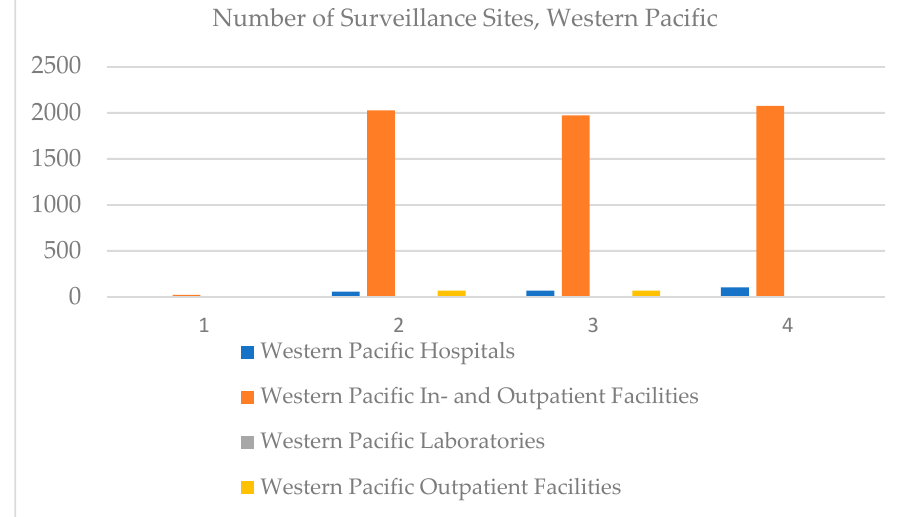
Figure 8. Number of surveillance sites, South-East Africa, 2017–2020. In the Western Pacific, the number of in- and outpatient hospitals has increased over time, the number of outpatient facilities has stagnated, and there are no on-board clinics registered (Figure 9).